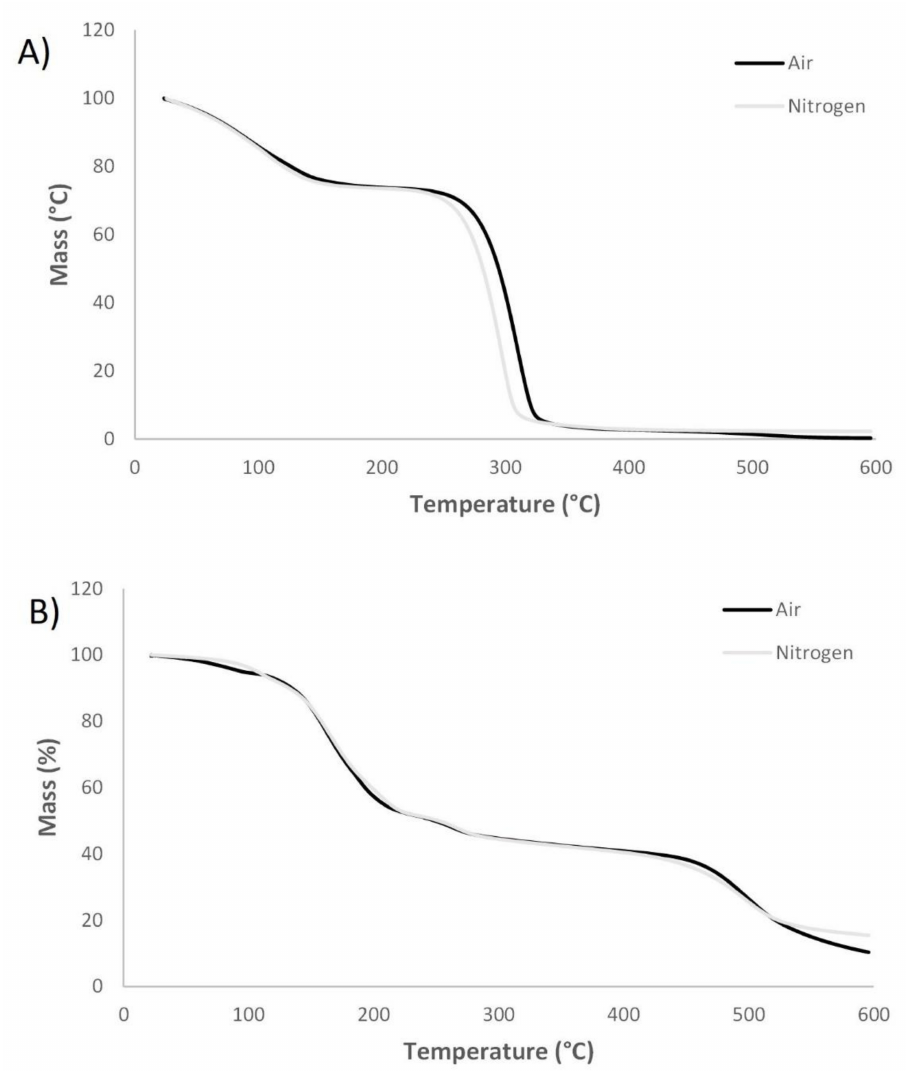
Figure 5. TGA curves of unmodified isosorbide in air and nitrogen ( A ) and modified isosorbide in air and nitrogen ( B